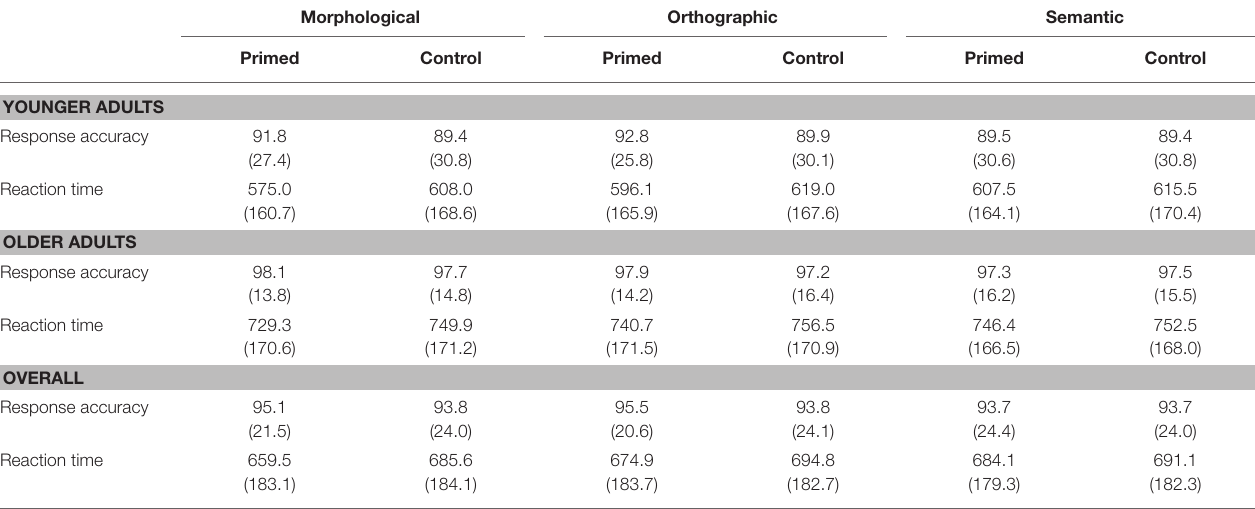
TABLE 2 | Response accuracy and response times (RTs) in means (and standard deviations) for all priming conditions in each participant G ROUP (younger vs.